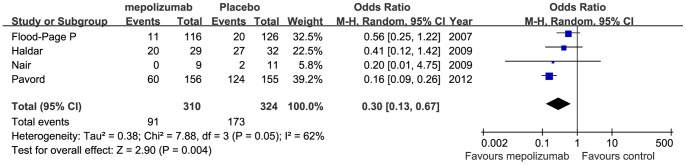
The effects of mepolizumab on exacerbation rates.